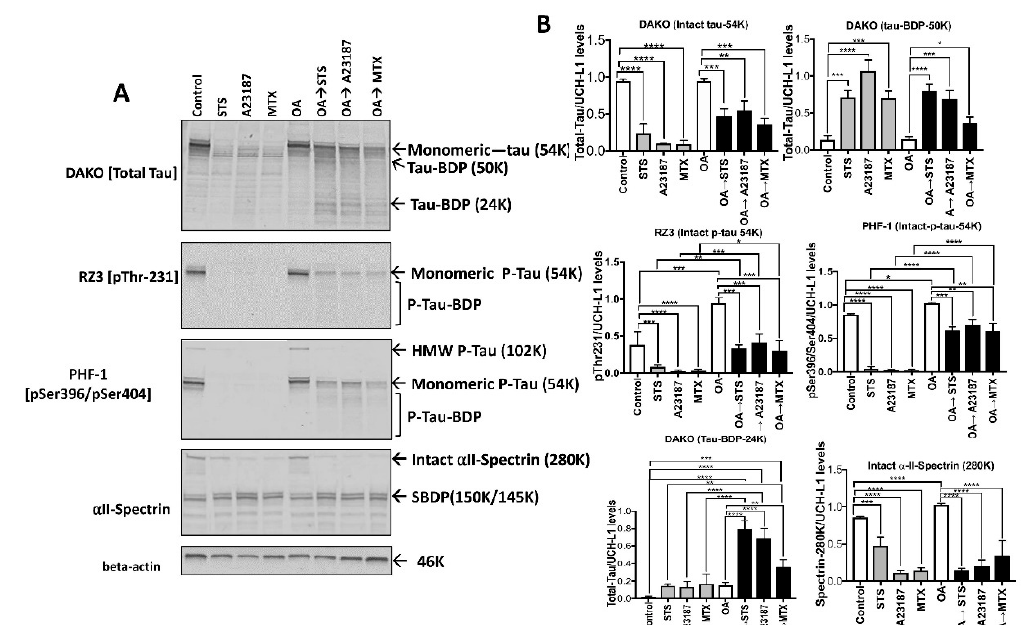
Figure 7. Basal and okadaic acid (OA)-induced tau proteolysis following neurotoxin challenges in di ff erentiated rat primary cerebrocortical neurons. Basal and OA-induced tau proteolysis following neurotoxin challenges in rat cerebrocortical neurons. ( A ) Rat cerebrocortical cultures (CTX) were either untreated (control) or pre-treated with a phosphatase inhibitor (OA, 100 nM) for 16 h. For tau proteolysis analysis, cultures were treated with neurotoxin agents including STS (0.5 µ M), A23187 (20 µ M) and MTX (10 nM). After the treatment, cell lysates were harvested for protein and immunoblotting analysis with total tau monoclonal antibody (DAKO; top panel), phospho-tau antibodies (RZ3 and PHF-1), and α II-spectrin monoclonal antibody. The beta-actin antibody was used as a loading control. Results are representative of three independent experiments. ( B ) Show densitometric quantifications from the immunoblots. Data are presented as ± SEM for n = 3. Statistical analysis was performed with one-way ANOVA. For multiple comparisons, one-way ANOVA followed by the Bonferroni’s post-hoc test was performed. * p < 0.05, ** p < 0.01, *** p < 0.001, **** p < 0.0001, and ns: non-significant.